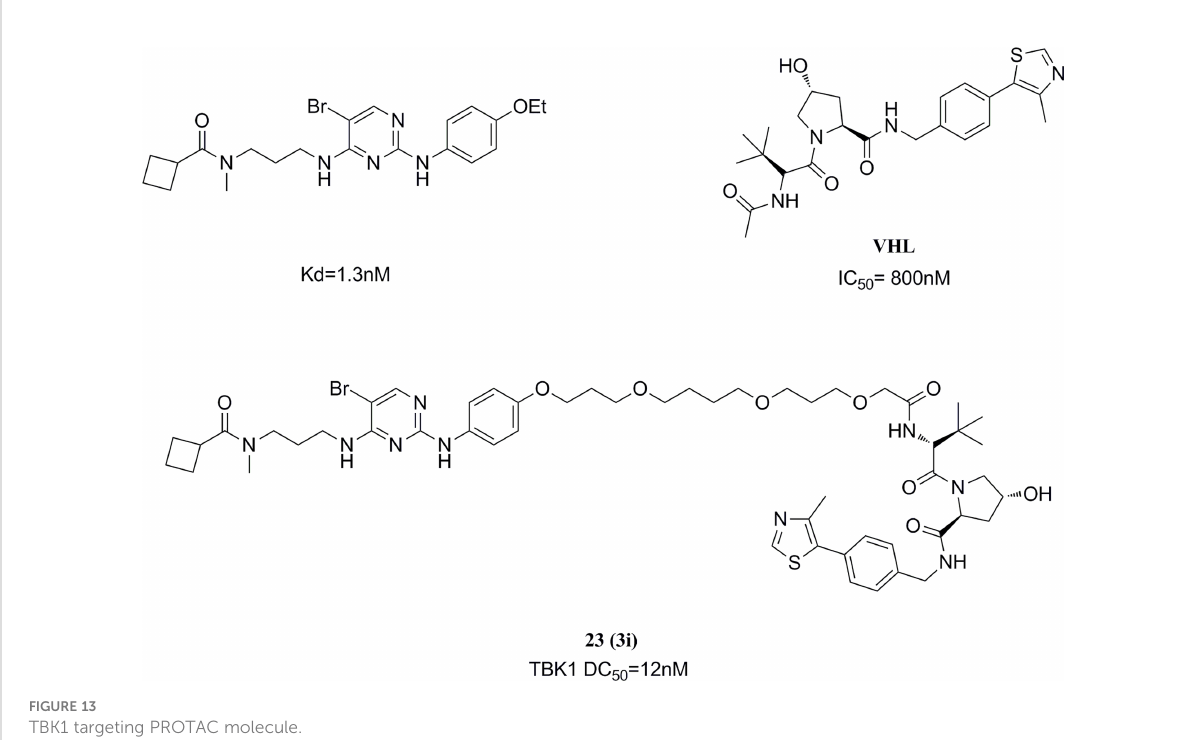
FIGURE 13 TBK1 targeting PROTAC